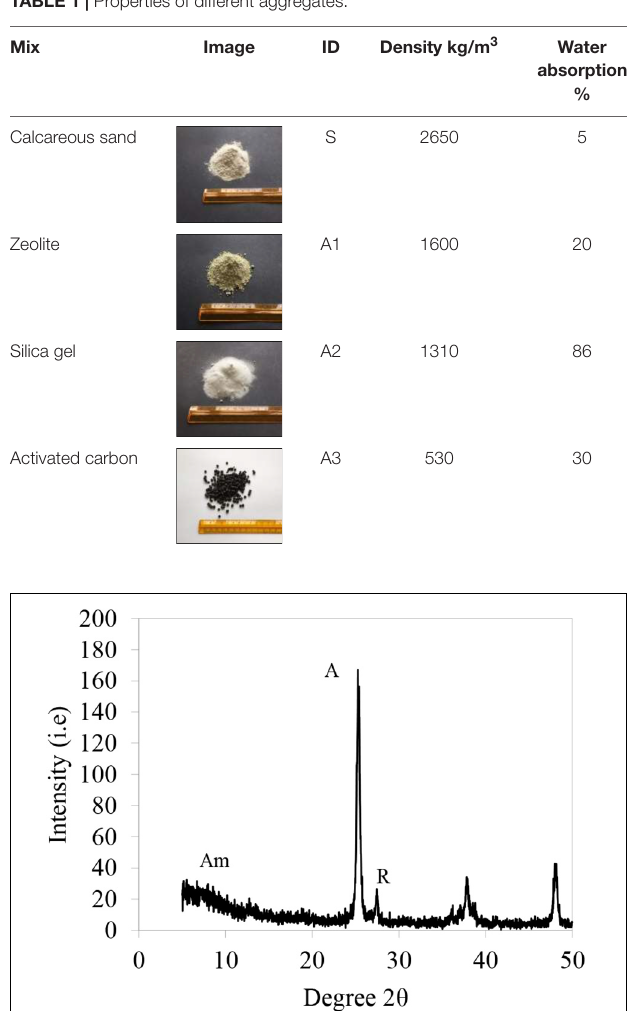
FIGURE 1 | X-ray diffraction (XRD) patterns of TiO 2 , P-25 where anatase (A), rutile (R), and the amorphous phase (Am) are